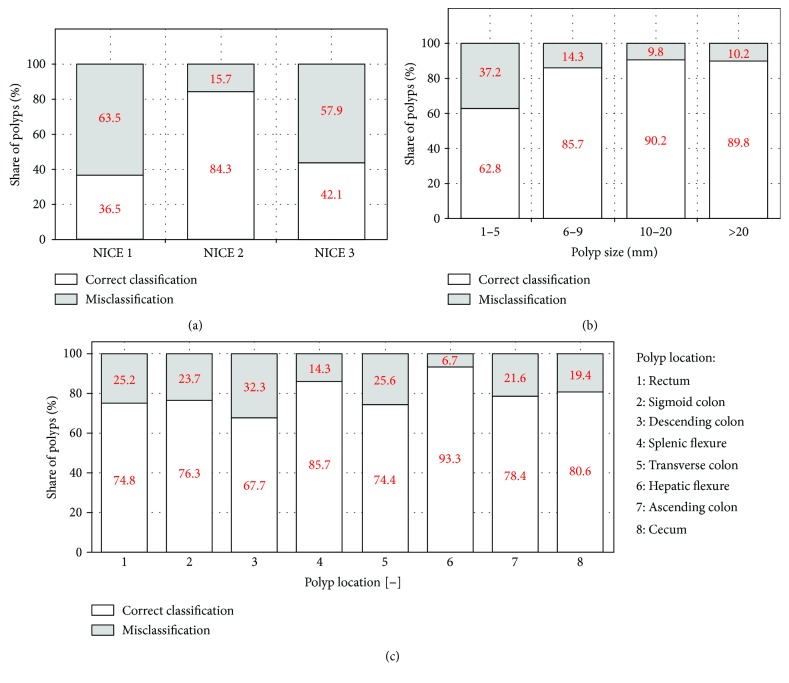
Share of correct classification and misclassification over different NICE types (a), different polyp sizes (b), and different polyp locations (1–8) (c).